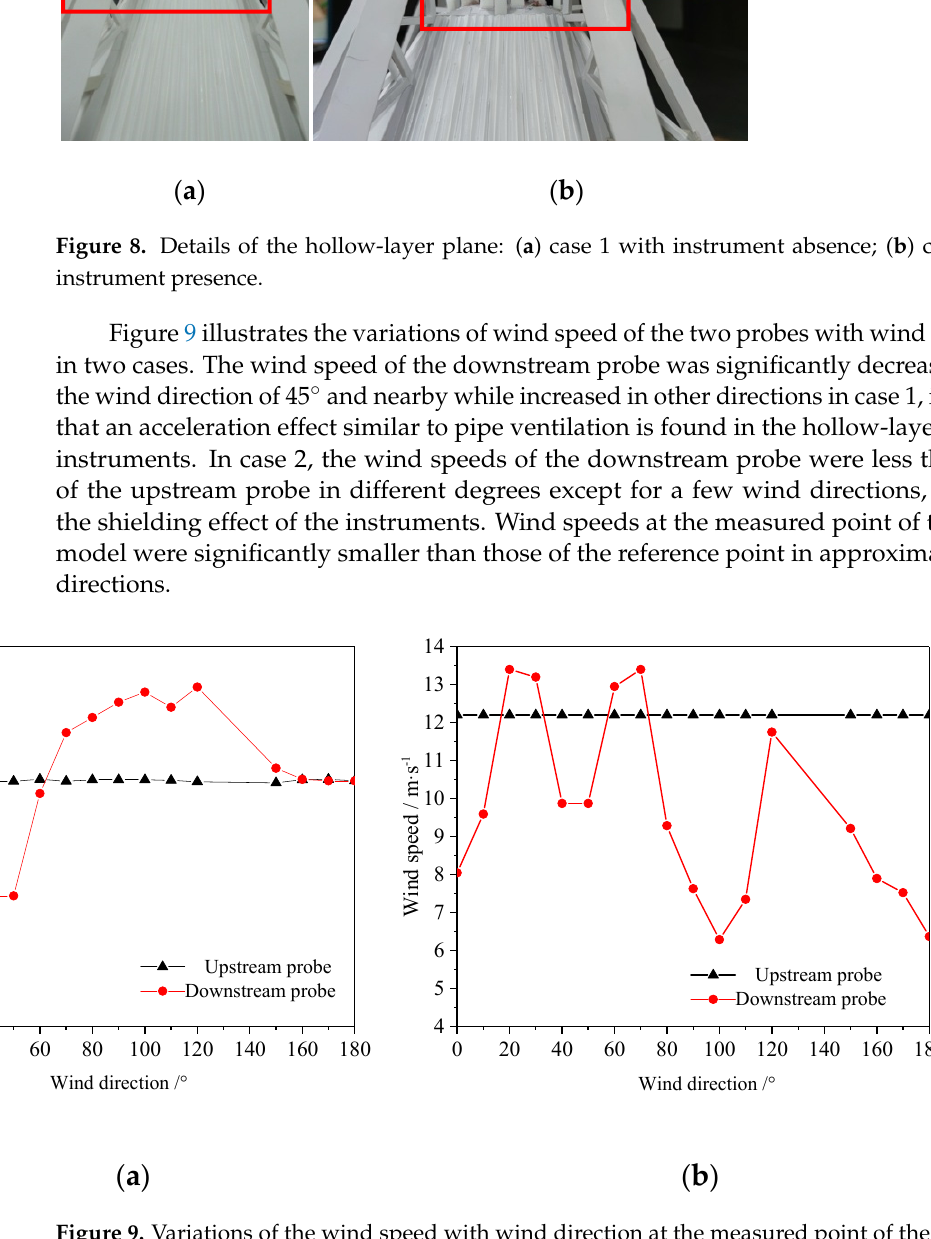
Figure 9. Variations of the wind speed with wind direction at the measured point of the segmental model of PAFC: ( a ) wind regime of case 1; ( b ) wind regime of case 2.